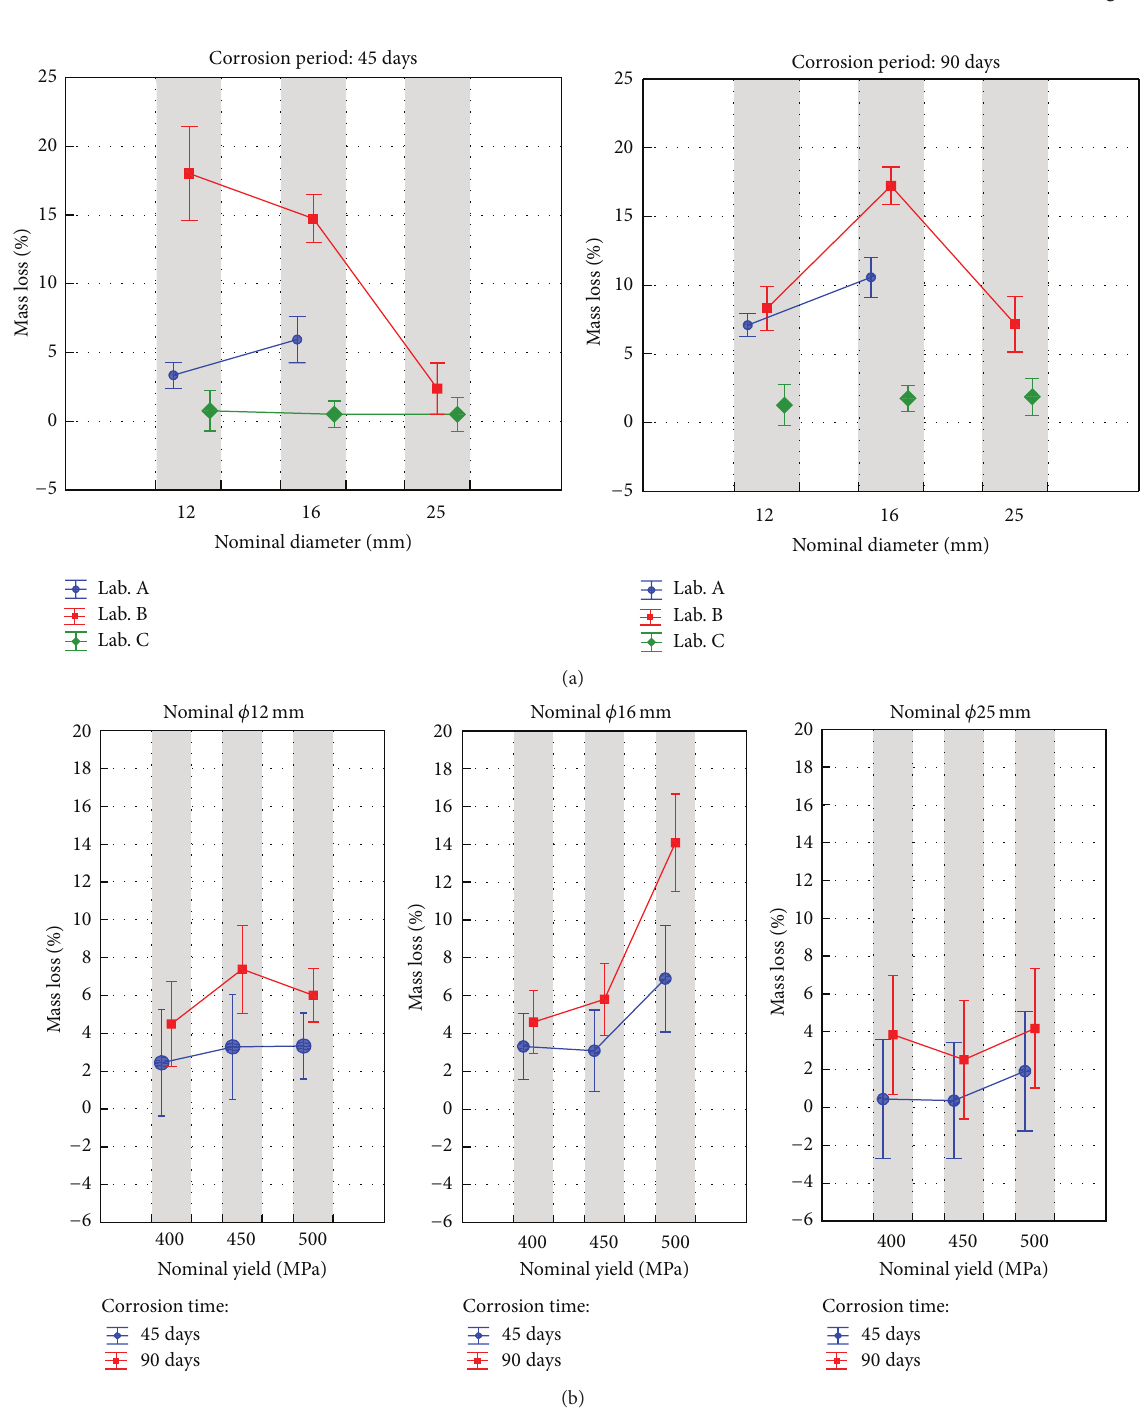
Figure 6: (a) ANOVA for the independent parameters Institute, nominal diameter, and corrosion time on mass loss, (b) ANOVA for the independent parameters nominal yield strength, nominal diameter, and corrosion time on mass